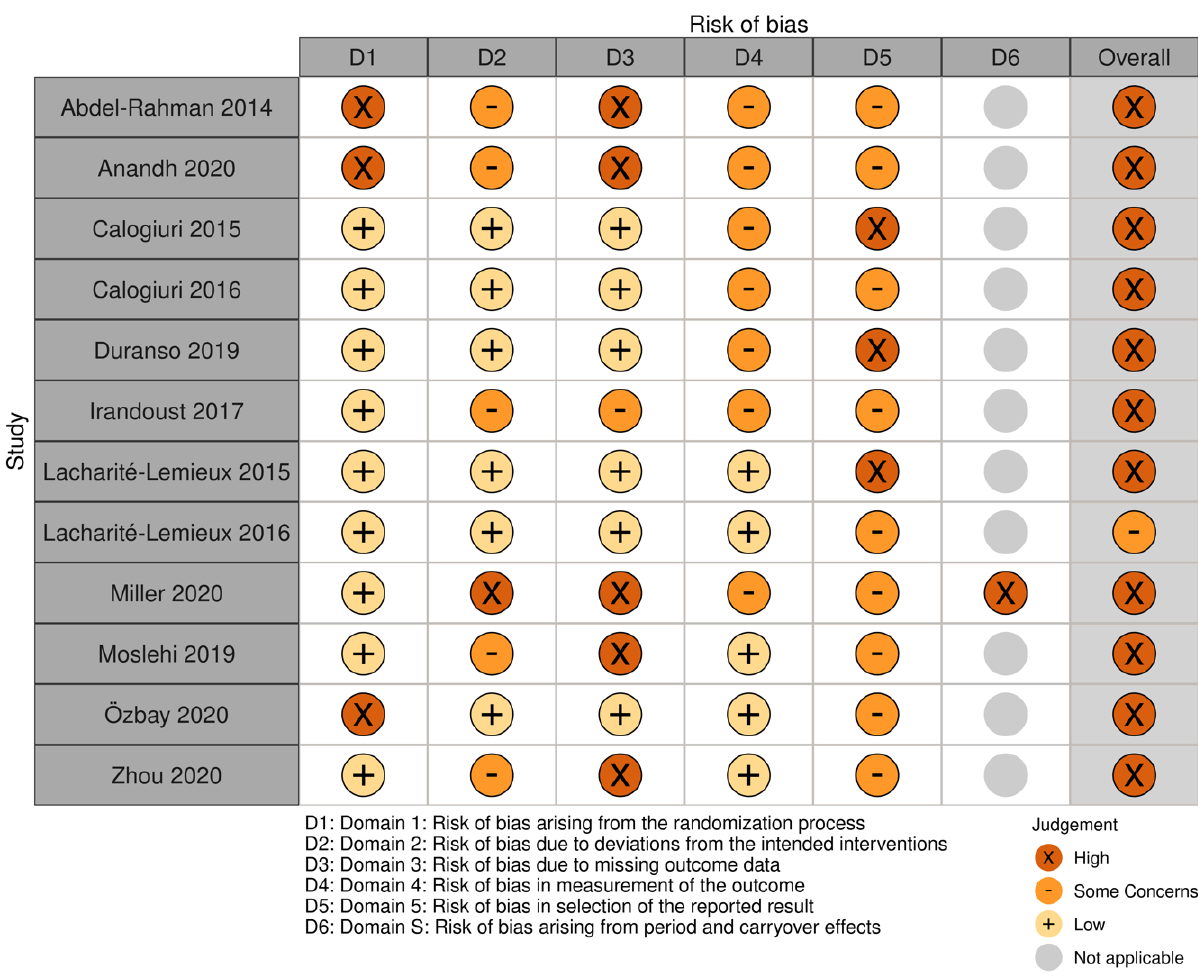
Figure 2. Summary of domain-level risk of bias judgements for each included article.